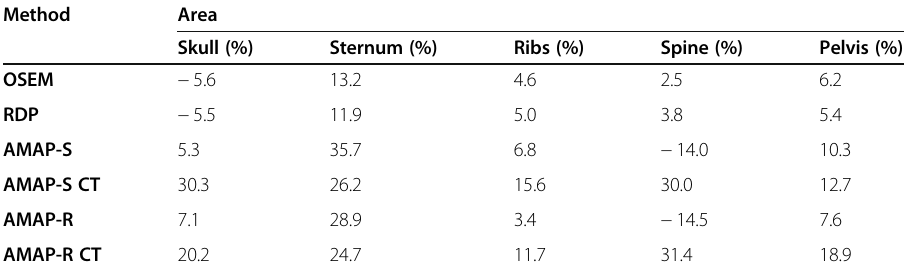
Table 3 Relative difference (100% × (SUV mean_true − SUV mean_5mm )/SUV mean_true ) in SUV mean values for the 4 different reconstruction algorithms generated by 5 mm mismatch between SPECT and CT. AMAP-S and AMAP-R refer to reconstructions where lesion is absent in the CT and AMAP-S CT and AMAP-R CT to lesion-present cases Method